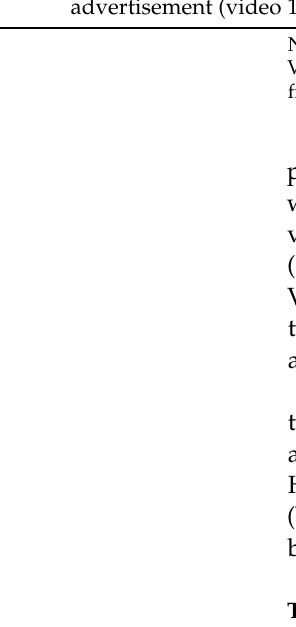
Table 3. Direct, indirect, total effect, type of mediation, and results of tests concerning video